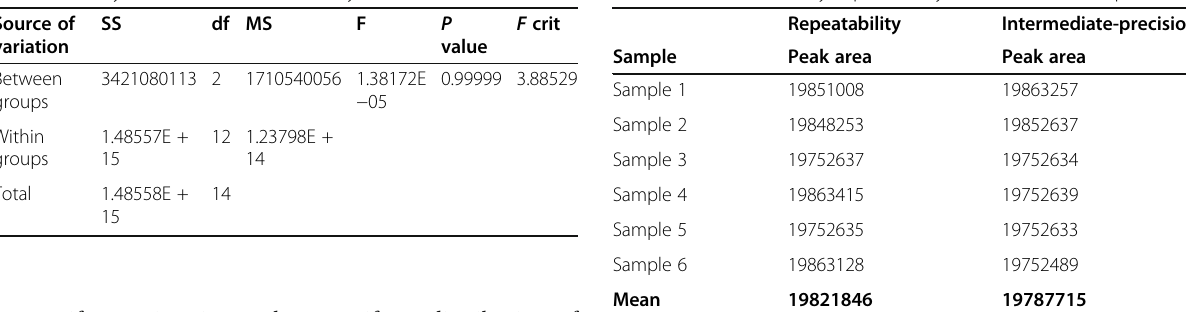
Table 4 Analysis of variance for linearity Table 6 Precision study-repeatability and intermediate